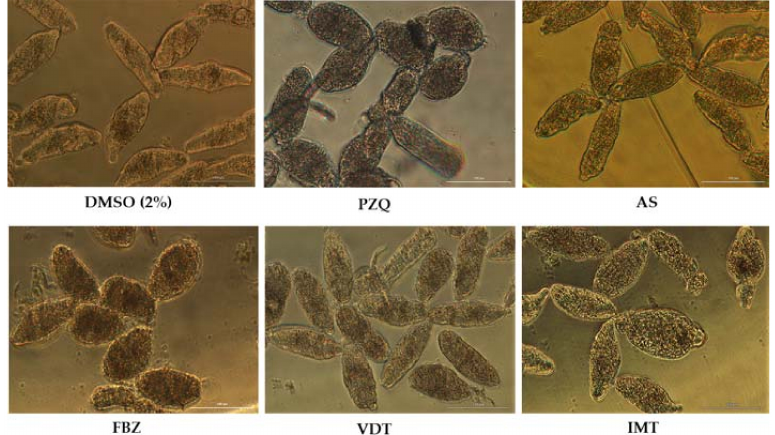
Figure 1. Representative micrographs of newly transformed schistosomula (NTS) at 72 h of exposure to the anthelmintics praziquantel (PZQ), artesunate (AS), and flubendazole (FBZ) and anticancer drugs vandetanib (VDT), and imatinib (IMT) at 100 µ M. Compared to controls, NTS incubated with drugs showed severe morphological alterations, and the morphological changes differed among the drugs. Scale bar, 100 µ